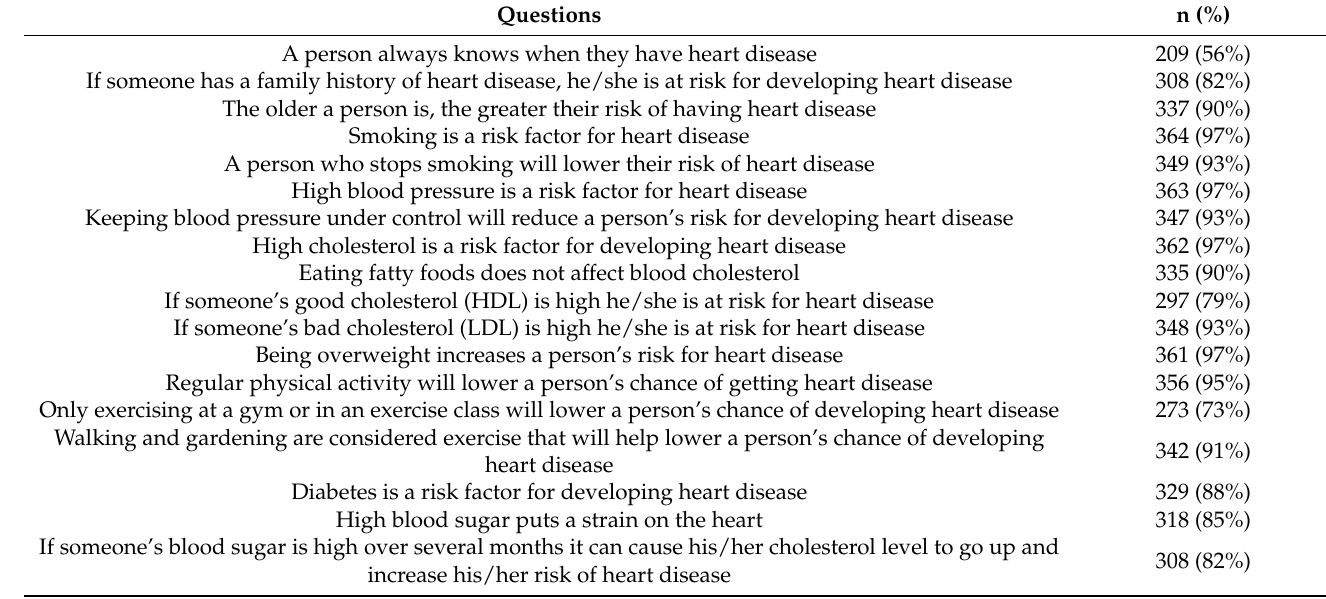
Table 2. Correct responses of HDFQ